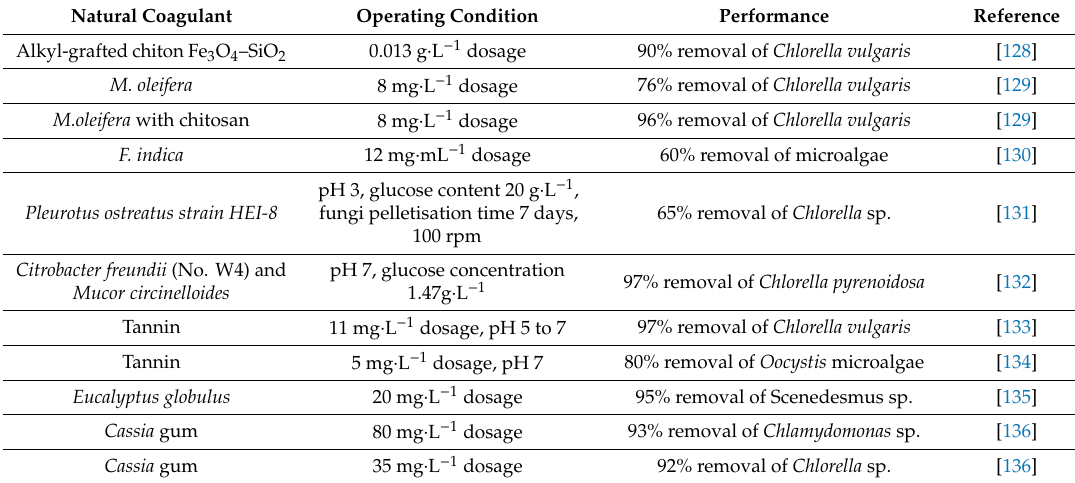
Table 4. Application of microalgae harvesting using natural coagulants.